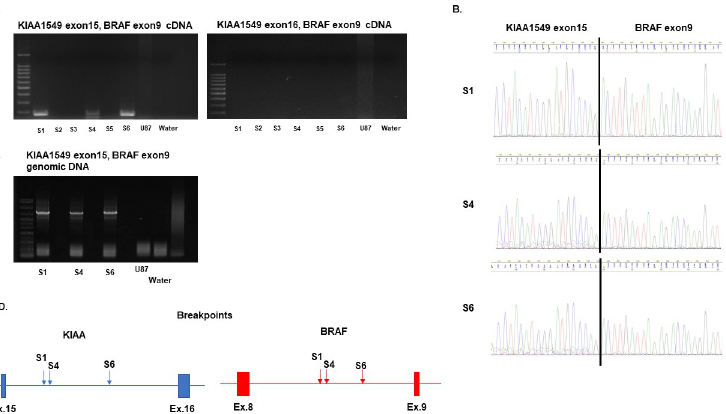
Fig 1. Screening for patient samples harboring the KIAA-BRAF fusion gene and breakpoint detection. (A) RT-PCR was performed to detect samples harboring the KIAA-BRAF fusion gene. cDNA of U87 and water were the negative controls. Among the six patient samples, S1, S4, and S6 expressed the KIAA1549 exon15, BRAF exon 9 fusion gene (left). None of the six samples manifested the KIAA1549 exon16, BRAF exon 9 fusion gene (right). (B) Sanger sequencing of S1, S4, and S6 revealed the KIAA1549 exon15, BRAF exon 9 fusion junctions. (C) LA-PCR assay of genomic DNA performed to obtain long amplified products including breakpoints. The genome of U87 and water were the negative controls. S1, S4, and S6 contained amplified products around 7 kb in length. (D) Breakpoints in S1, S4, and S6 detected by Sanger sequencing. Although the fusion pattern was the same, the breakpoints were different. For details, see S8 Fig.